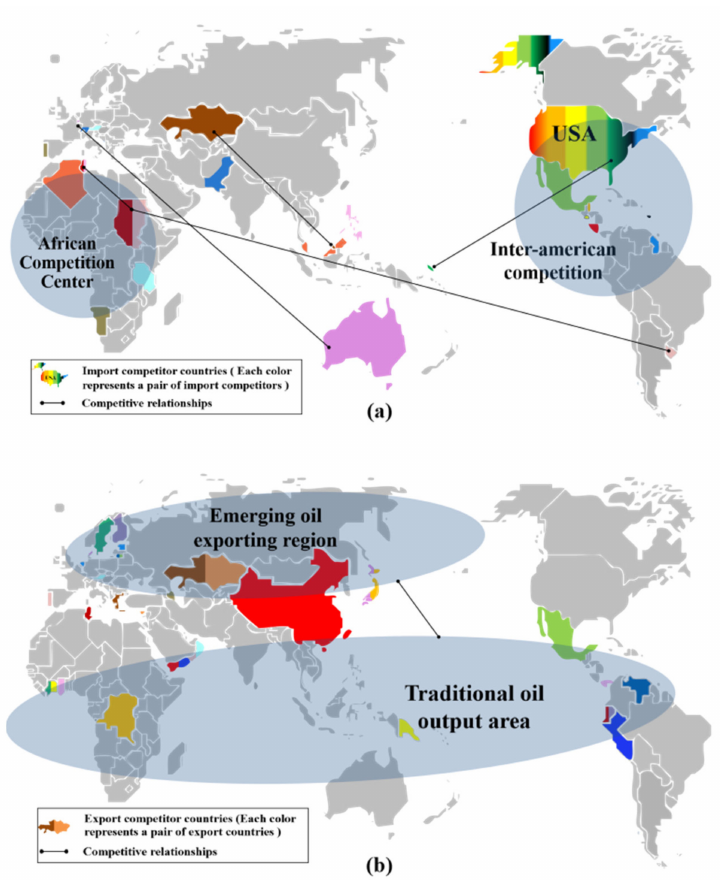
Figure 10. Potential competitive relationships analysis in the future. ( a ) Import Link Prediction results; ( b ) Export Link Prediction